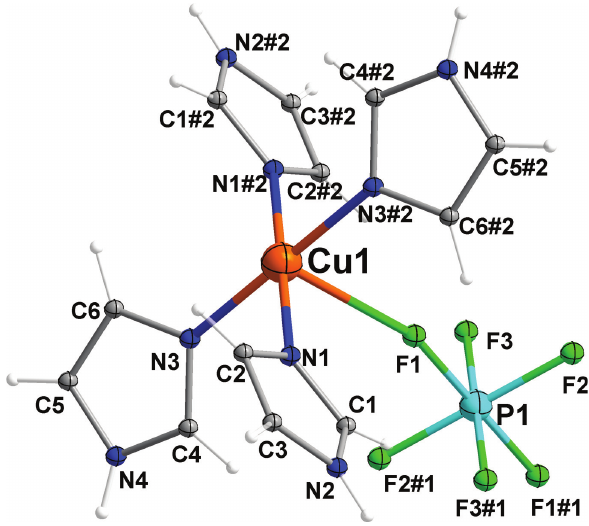
Table 1: Data collection and handling.